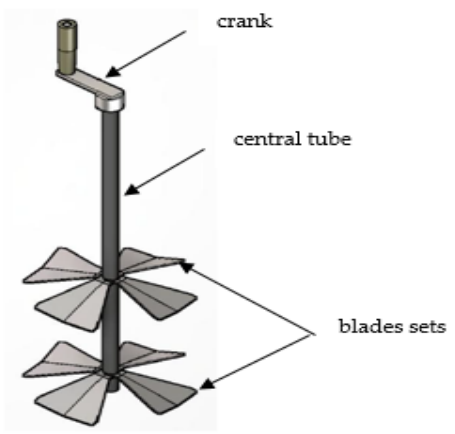
Figure 6. Turbine-type agitator with two sets of blades [9].